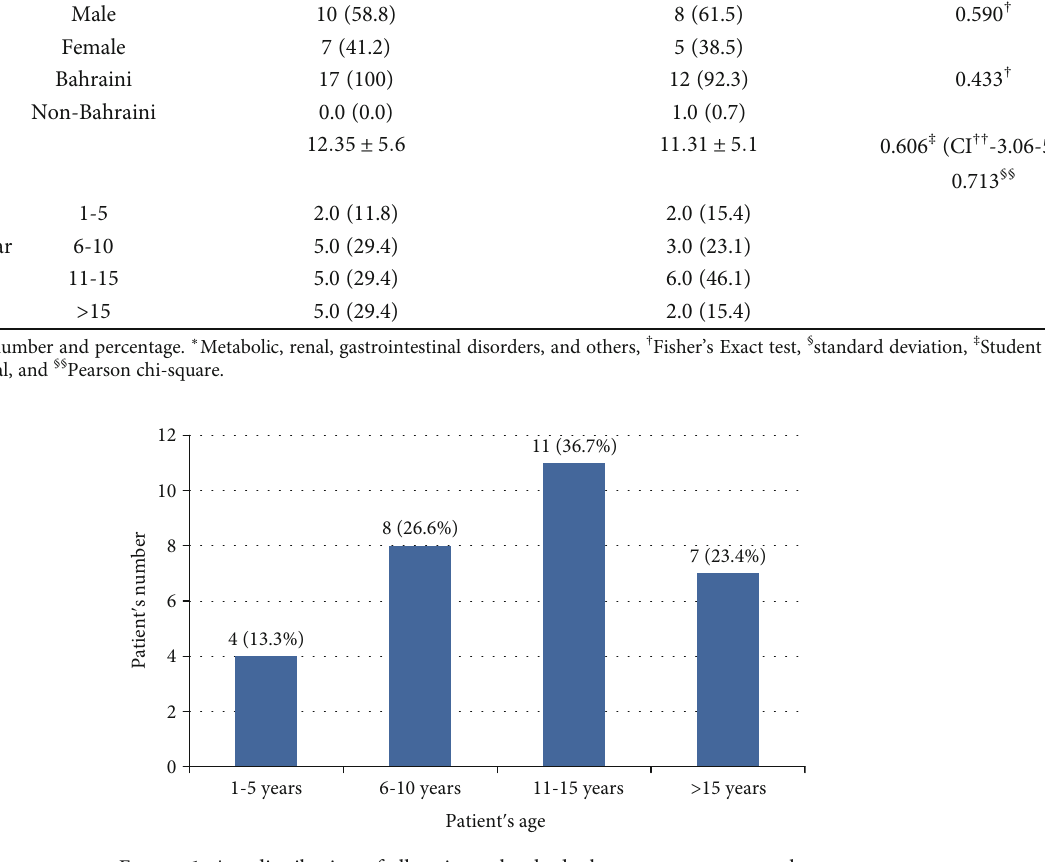
Figure 1: Age distribution of all patients that had a button gastrostomy